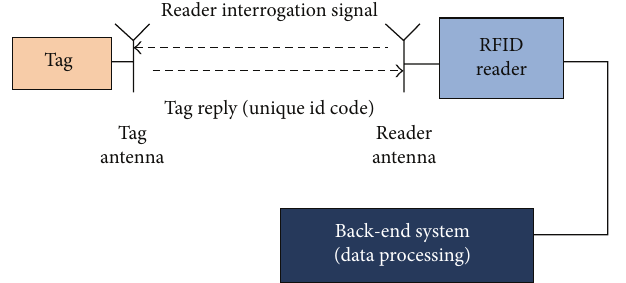
Figure 1: Basic RFID system